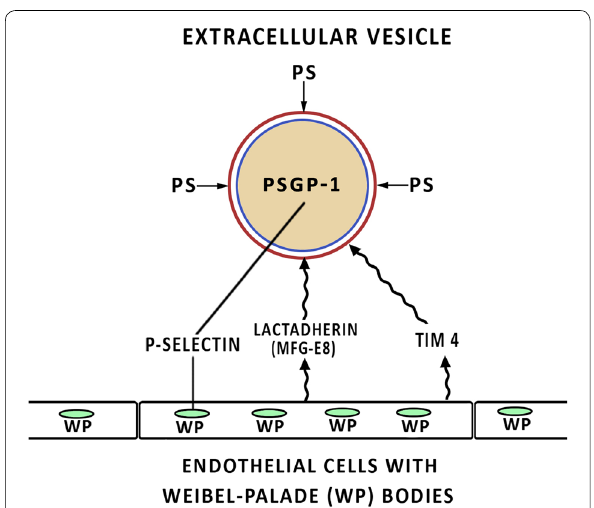
Fig. 2 Extracellular vesicle attachment to endothelial cells is depend- ent upon their exposed PSGL-1 attaching to the P-selectin expressed from Weibel–Palade bodies and platelet alpha-granules, and upon the tethering of the exposed surface phosphatidylserine to Tim4, lactadherin/MFG-E8 and probably other cell adhesion